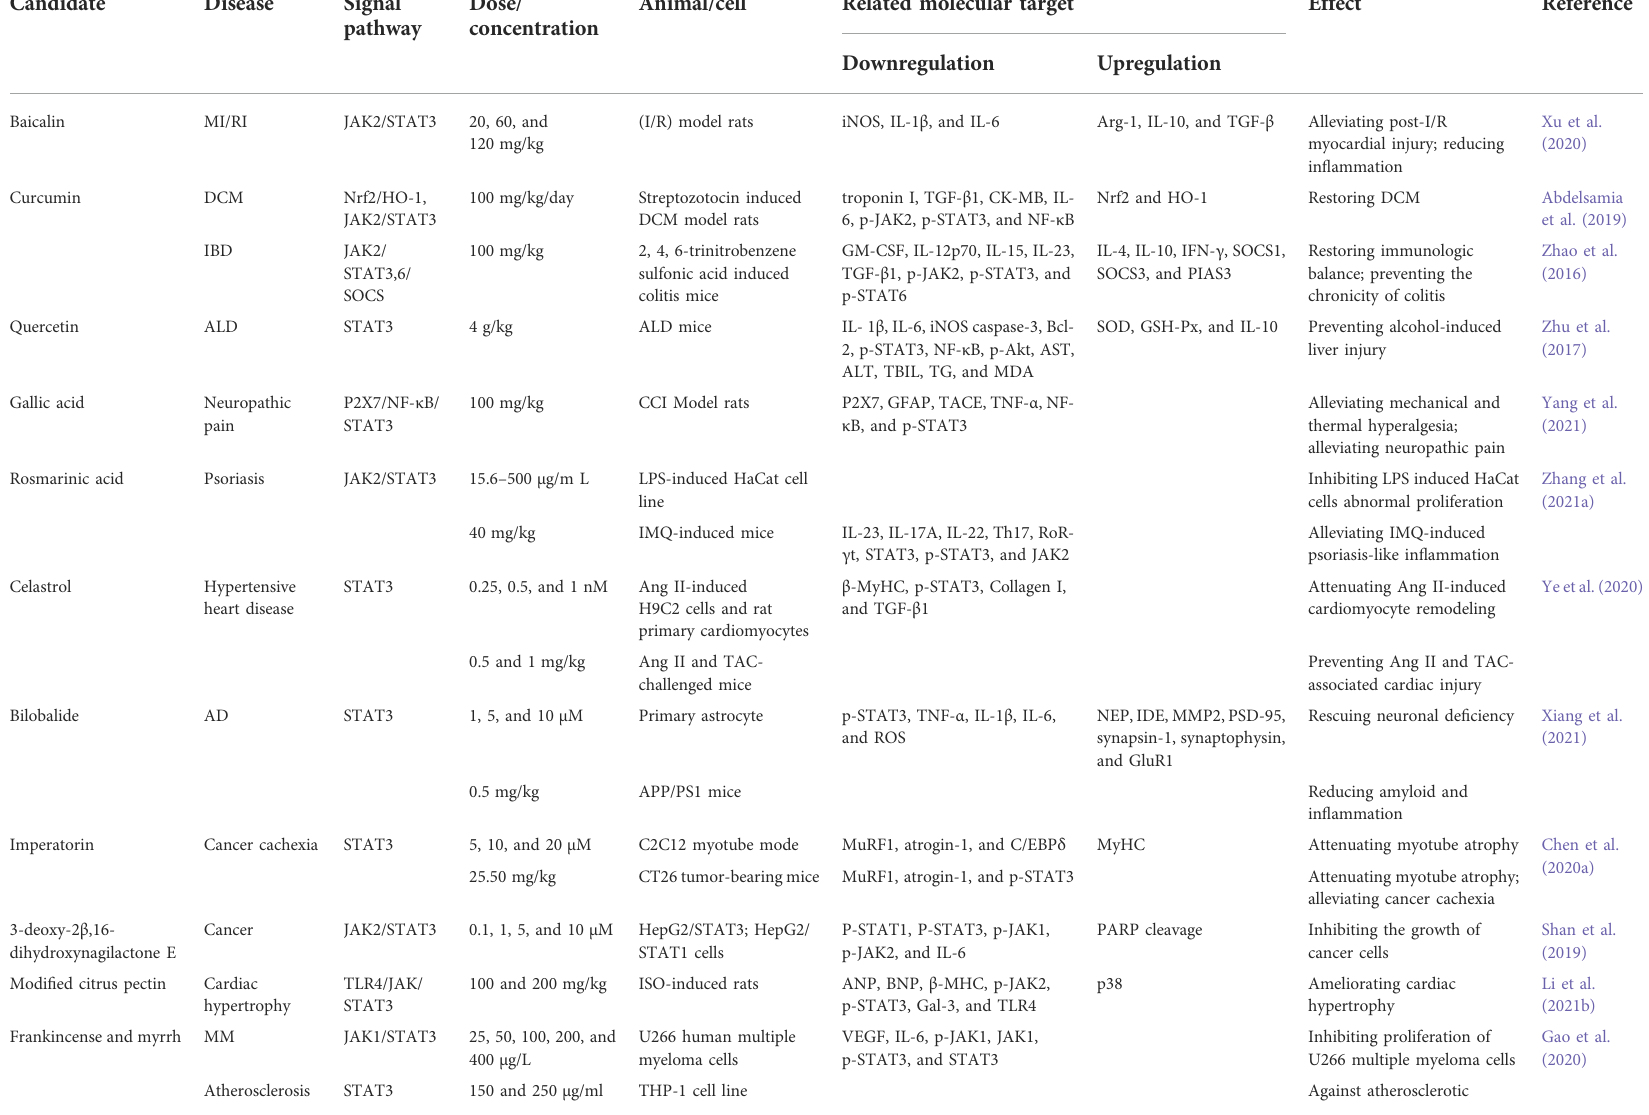
TABLE 3 Chinese herbal formulas or active ingredients in the treatment of infected or in fl ammatory diseases through affecting